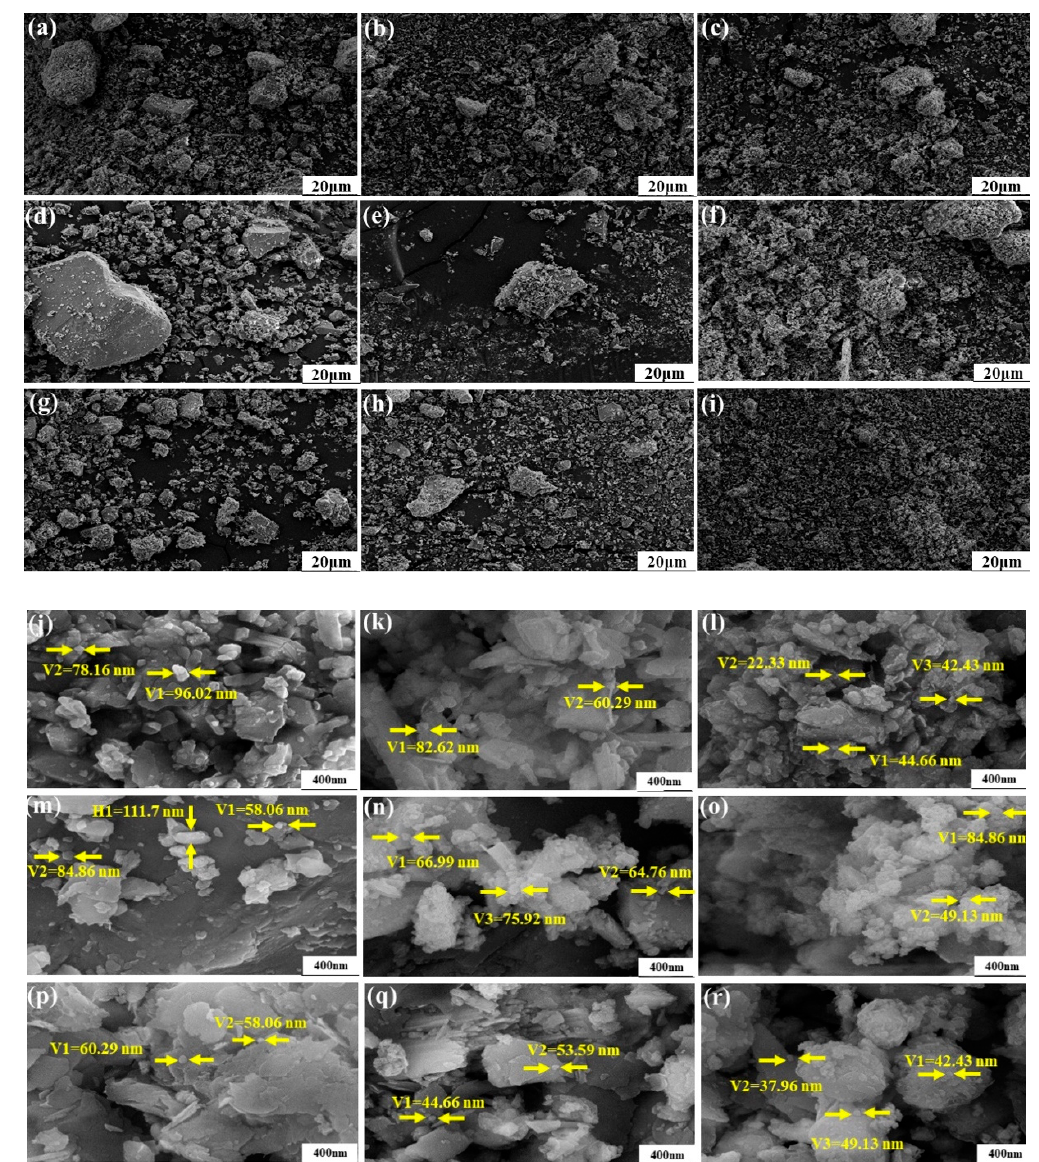
Figure 6. SEM images of three PR powder at different milling times: PR1 raw material ( a and j ), microcrystalline PR1 at 30 min ( b and k ) and 150 min ( c and l ); PR2 raw material ( d and m ), microcrystalline PR2 at 30 min ( e and n ) and 150 min ( f and o ); PR3 raw material ( g and p ), microcrystalline PR3 at 30 min ( h and q ) and 150 min ( i and r ).